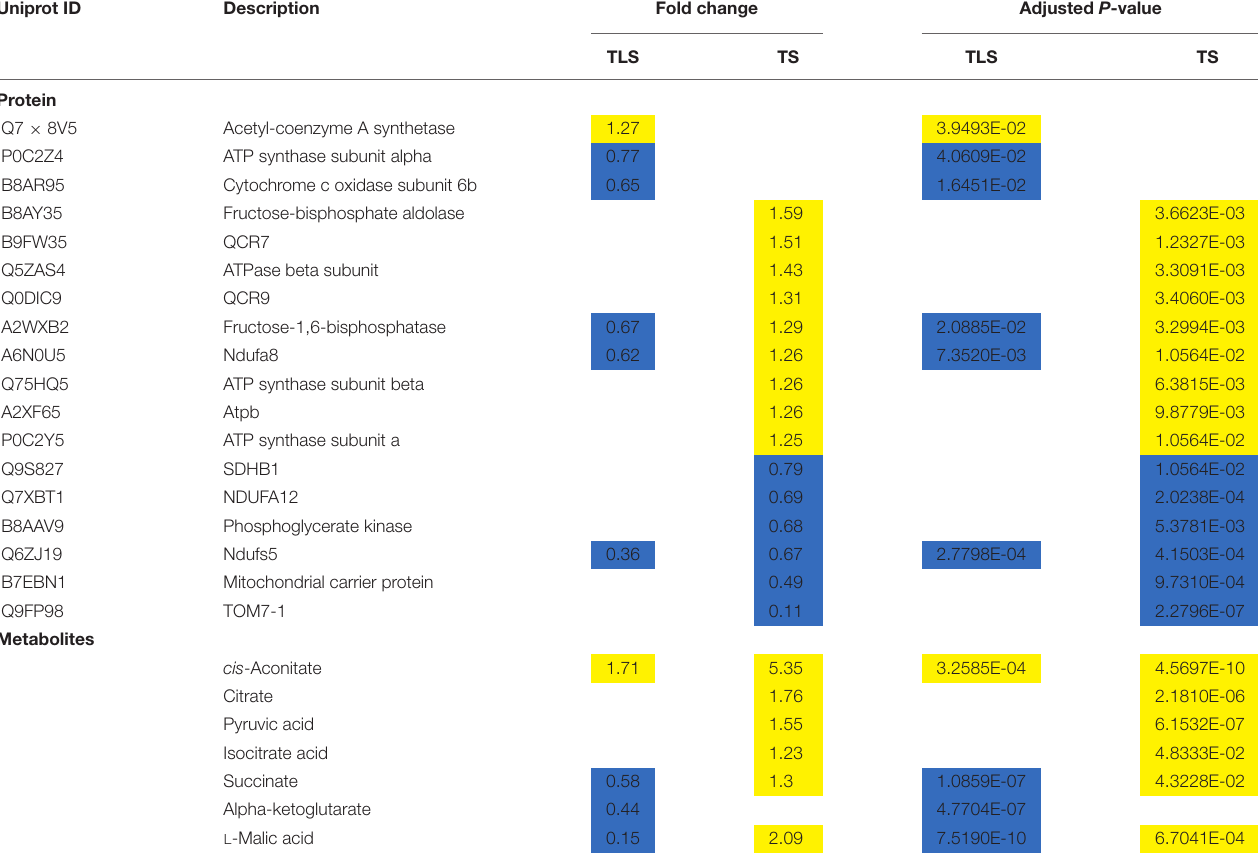
TABLE 6 | Differentially expressed proteins and metabolites related to energy metabolism. Uniprot